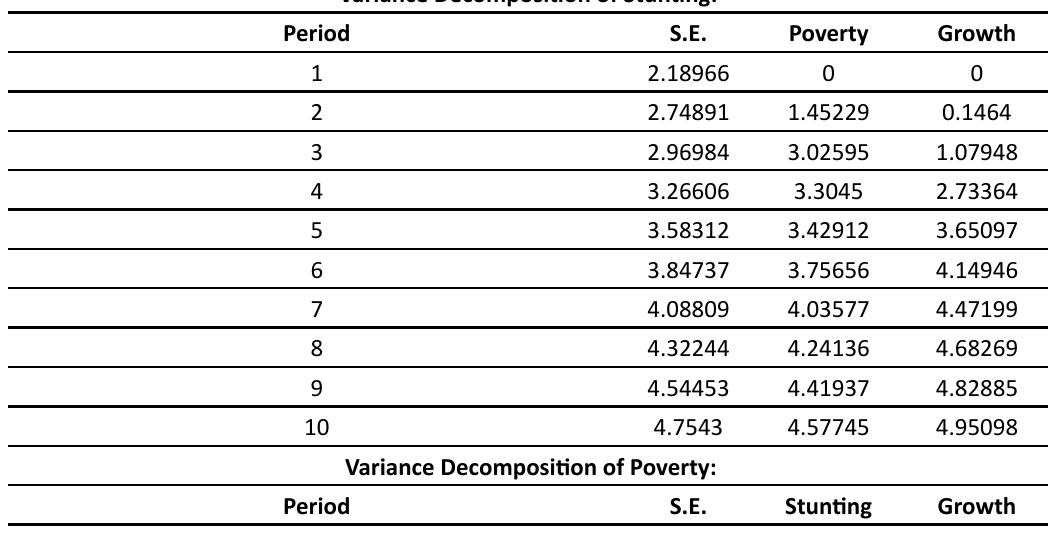
Table 7: Forecast Error Variance Decomposition Variance Decomposition of